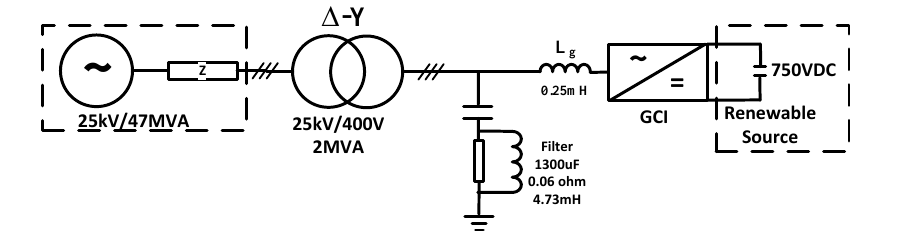
Figure 5. Simulation circuit.